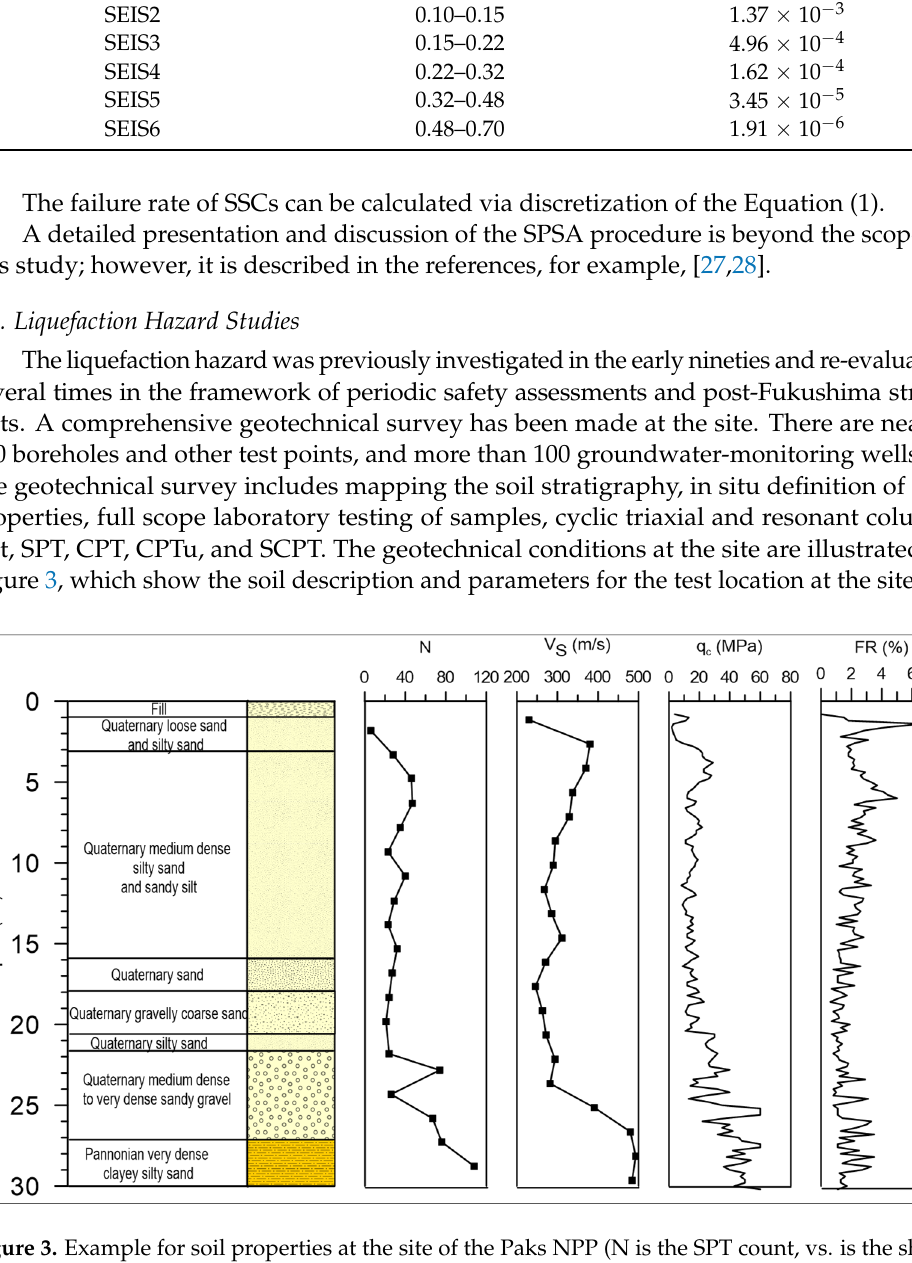
Table 1. Division of the seismic demand into calculation intervals.